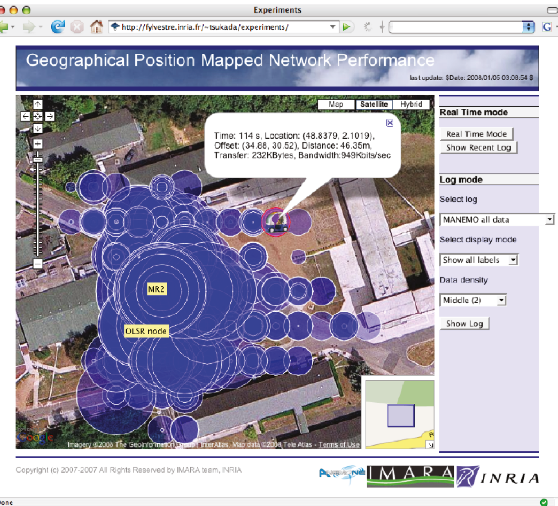
Figure 18: Website screen shot of the MANEMO experiment.